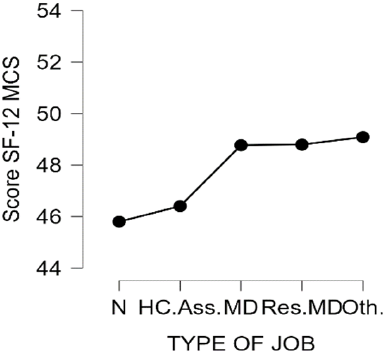
Figure 1. MCS score according to the type of job. N = Nurse; HC.Ass. = Healthcare Assistants; MD = Physicians; Res.MD = Resident Physicians; Oth = Others.